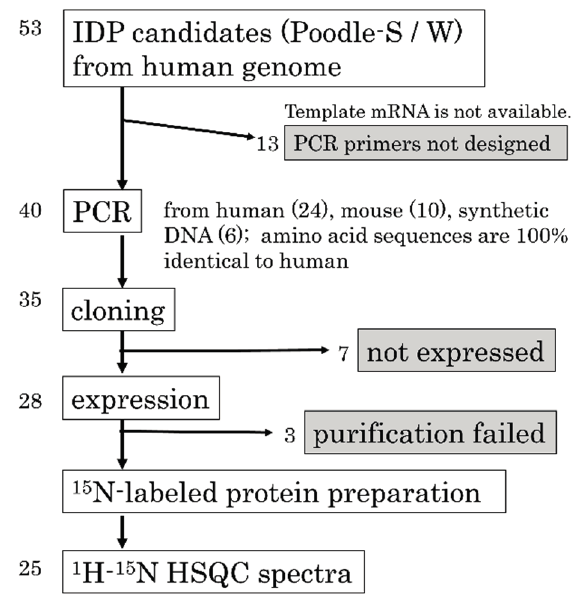
Figure 3. A workflow of the systematic assessment of intrinsically disordered proteins (IDPs) from the human